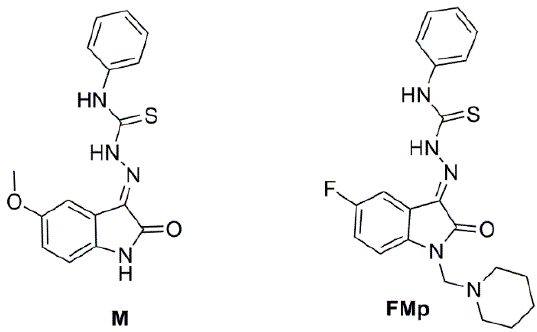
Figure 1. Chemical structure of the tested isatin thiosemicarbazones.